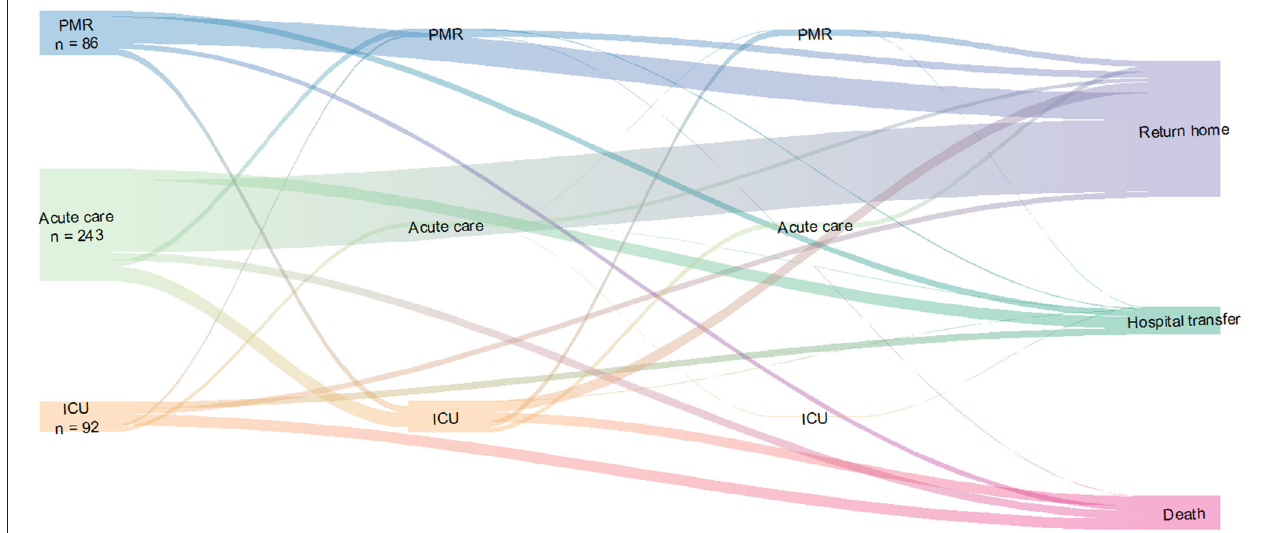
FIGURE 2 | Patients pathway in COVID-building during the pandemic. The thickness of the lines is proportional to the size of the patients’ flow. This flow diagram does not take into account the temporality. It describes the trajectory of the patients according to the passages in the different departments. PMR, physical medicine and rehabilitation; ICU, intensive care